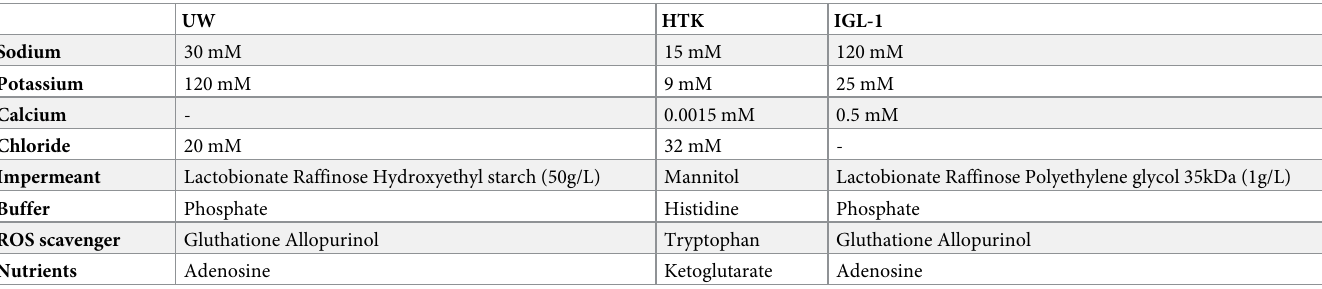
Table 1. Composition of the preservation solutions UW, HTK and IGL-1. [7]. UW